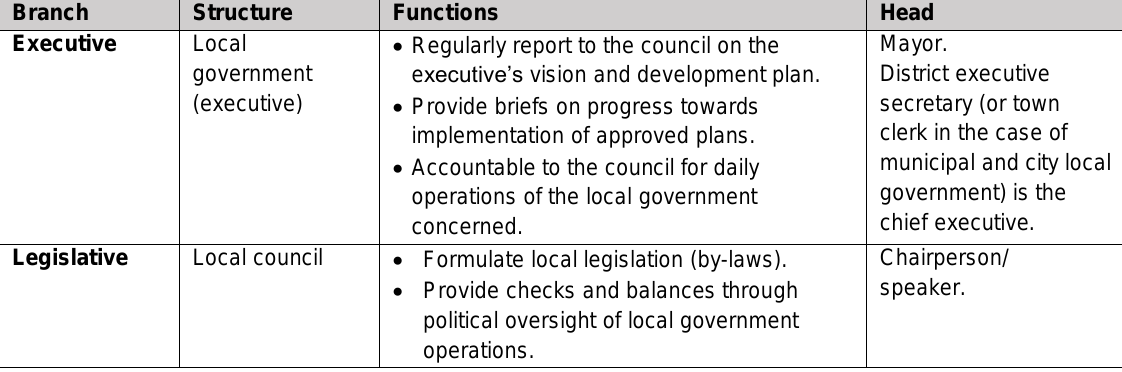
Table 4: Local government structure provided for in the